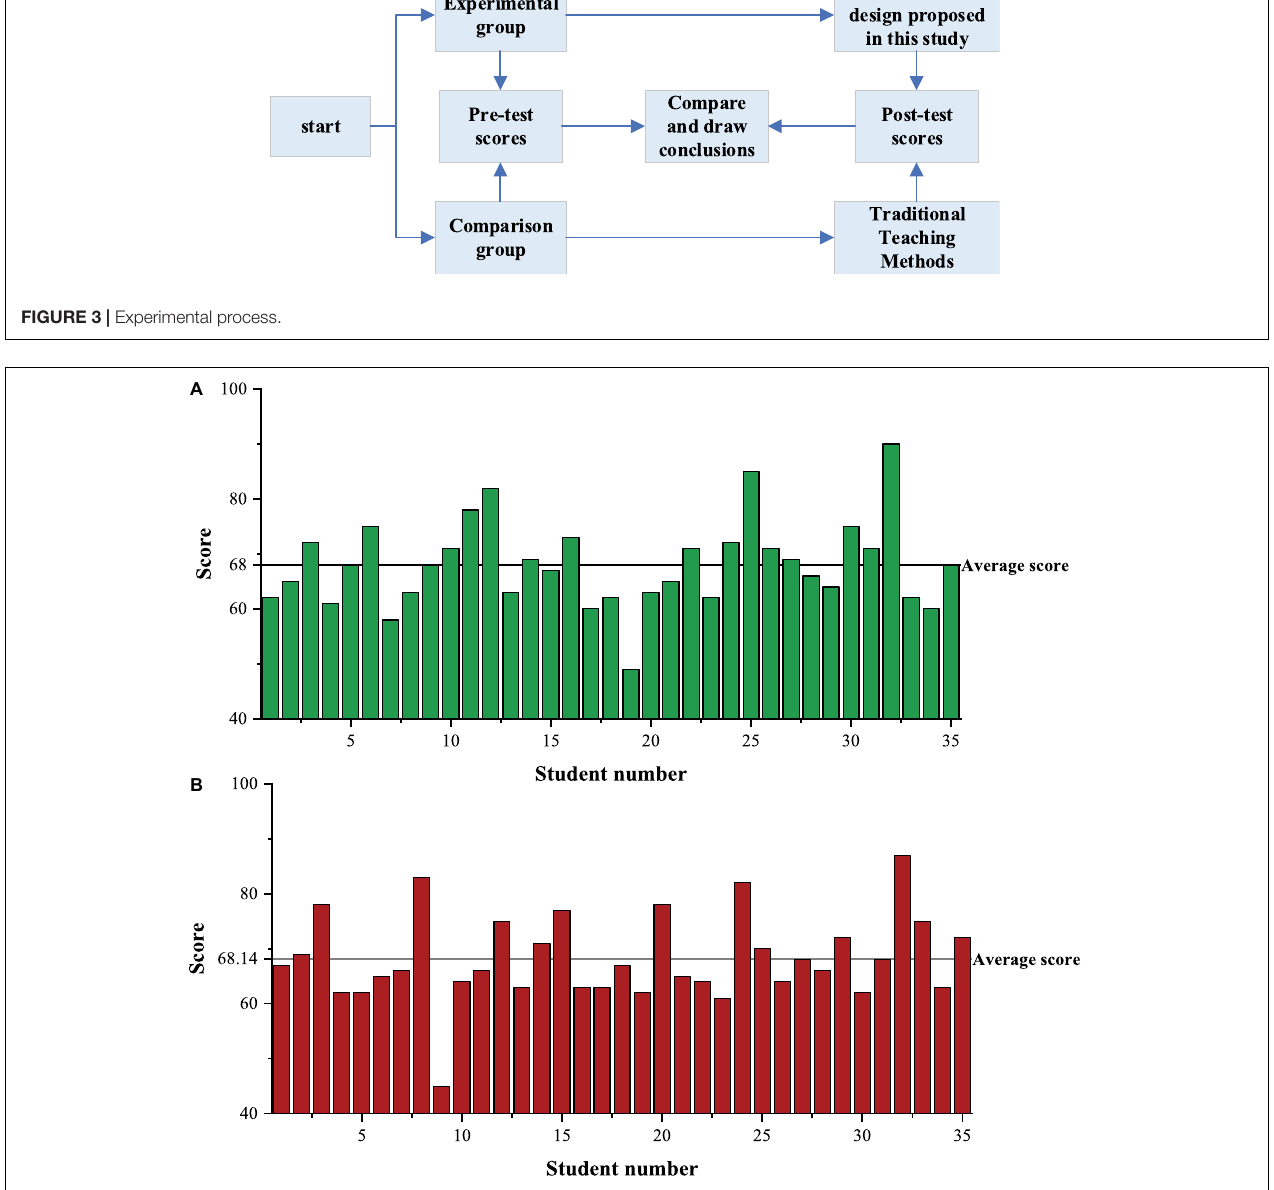
FIGURE 4 | Pre-test scores of students in Class A and B. (A) Is the pre-test score of Class A students, (B) is the pre-test score of Class B